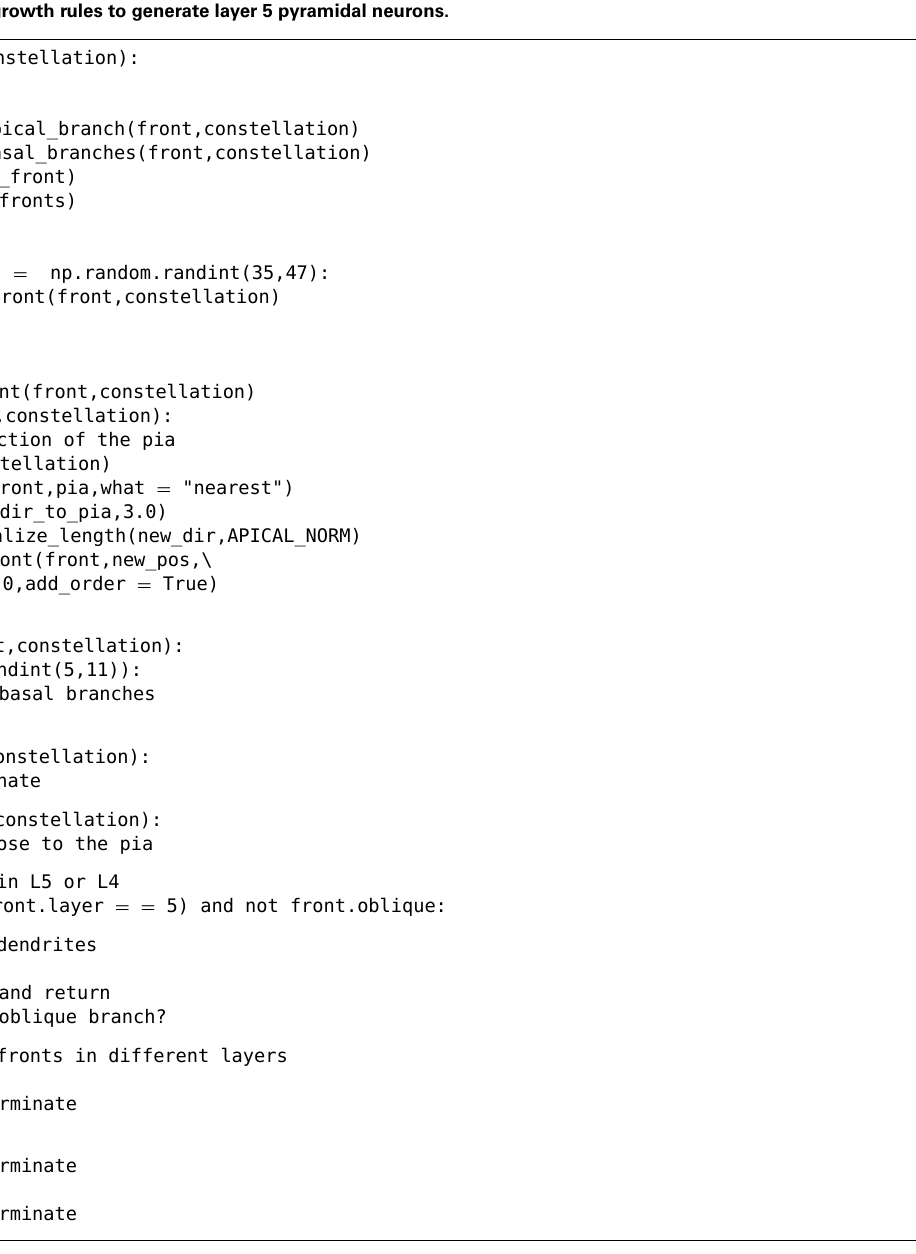
Table 5 | Code snippet illustrating the growth rules to generate layer 5 pyramidal